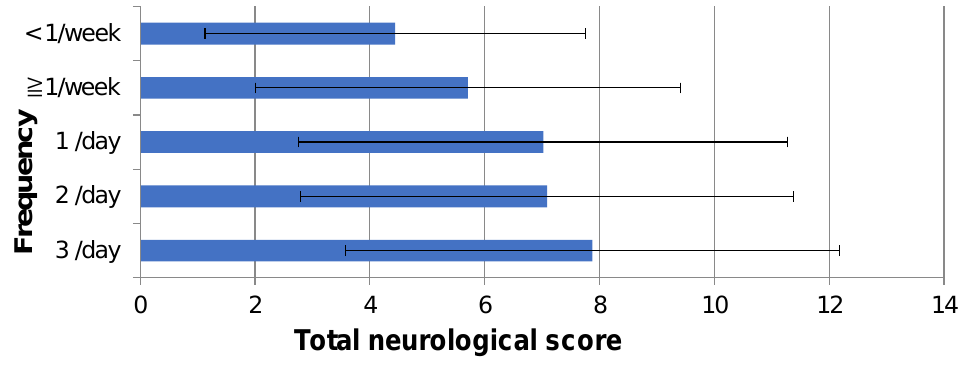
Figure 5. Scores and frequency of fish ingestion ( n = 973). Scores increased as the frequency of fish ingestion increased.